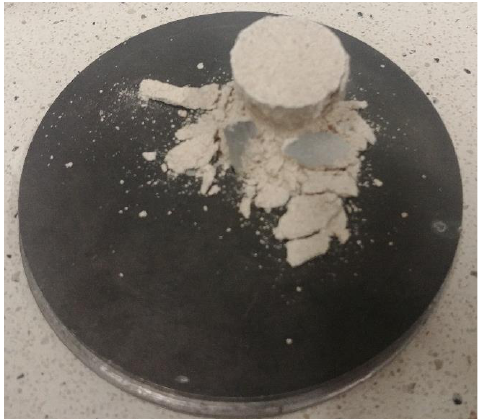
Figure 10: EDS analysis. 1.